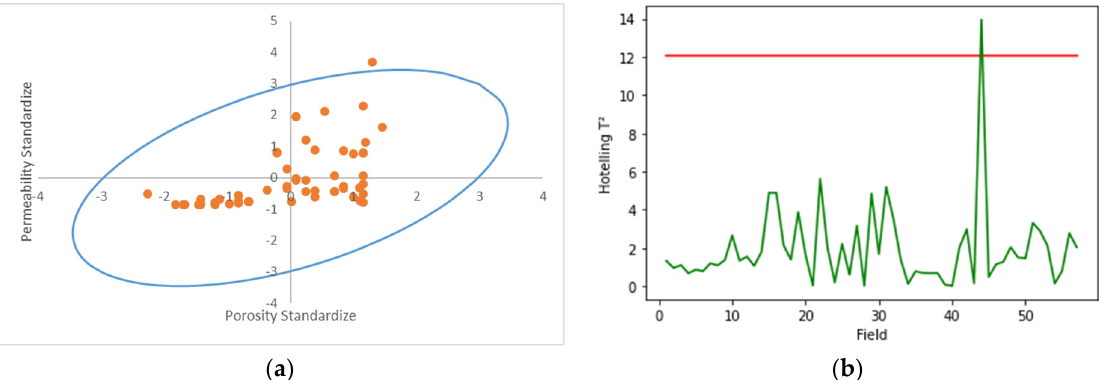
Figure 14. ( a ) Simultaneous boundary ellipse and ( b ) the Hotelling T 2 chart for immiscible CO 2 -EOR simultaneous screening model B.